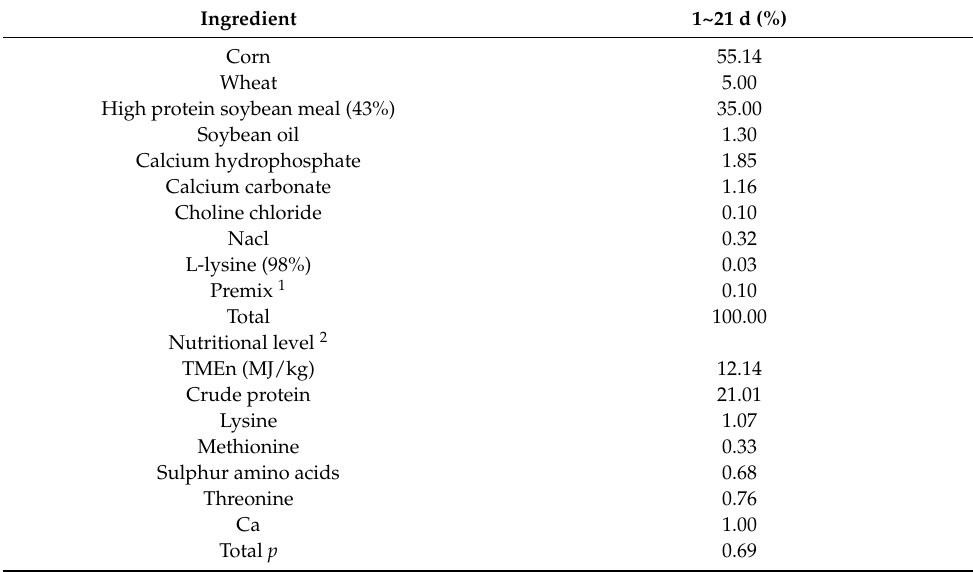
Table 1. Composition and nutrient levels of basal diet (air-dry basis,%).